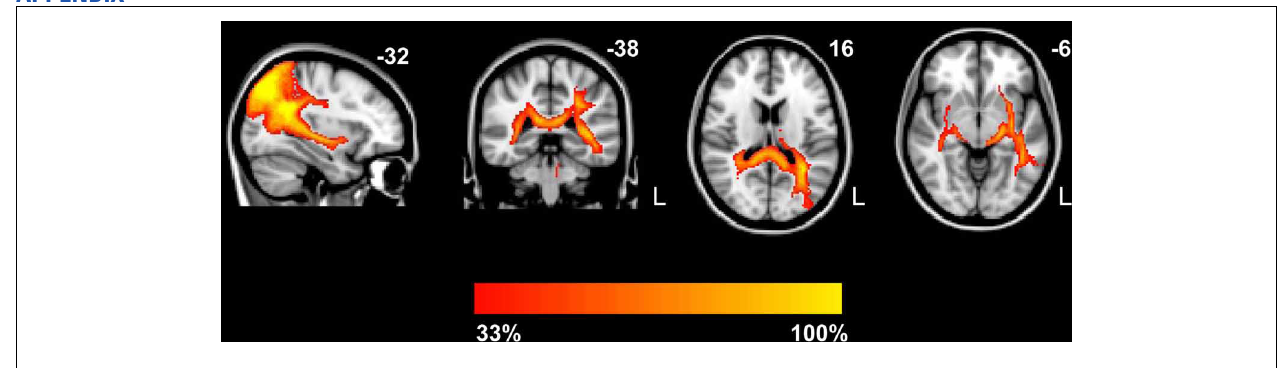
FIGURE A1 | Probabilistic maps of the tracts. Group probabilistic maps were set at a threshold so that only the paths present in at least one-third of the subjects are displayed. The fiber tracts include the